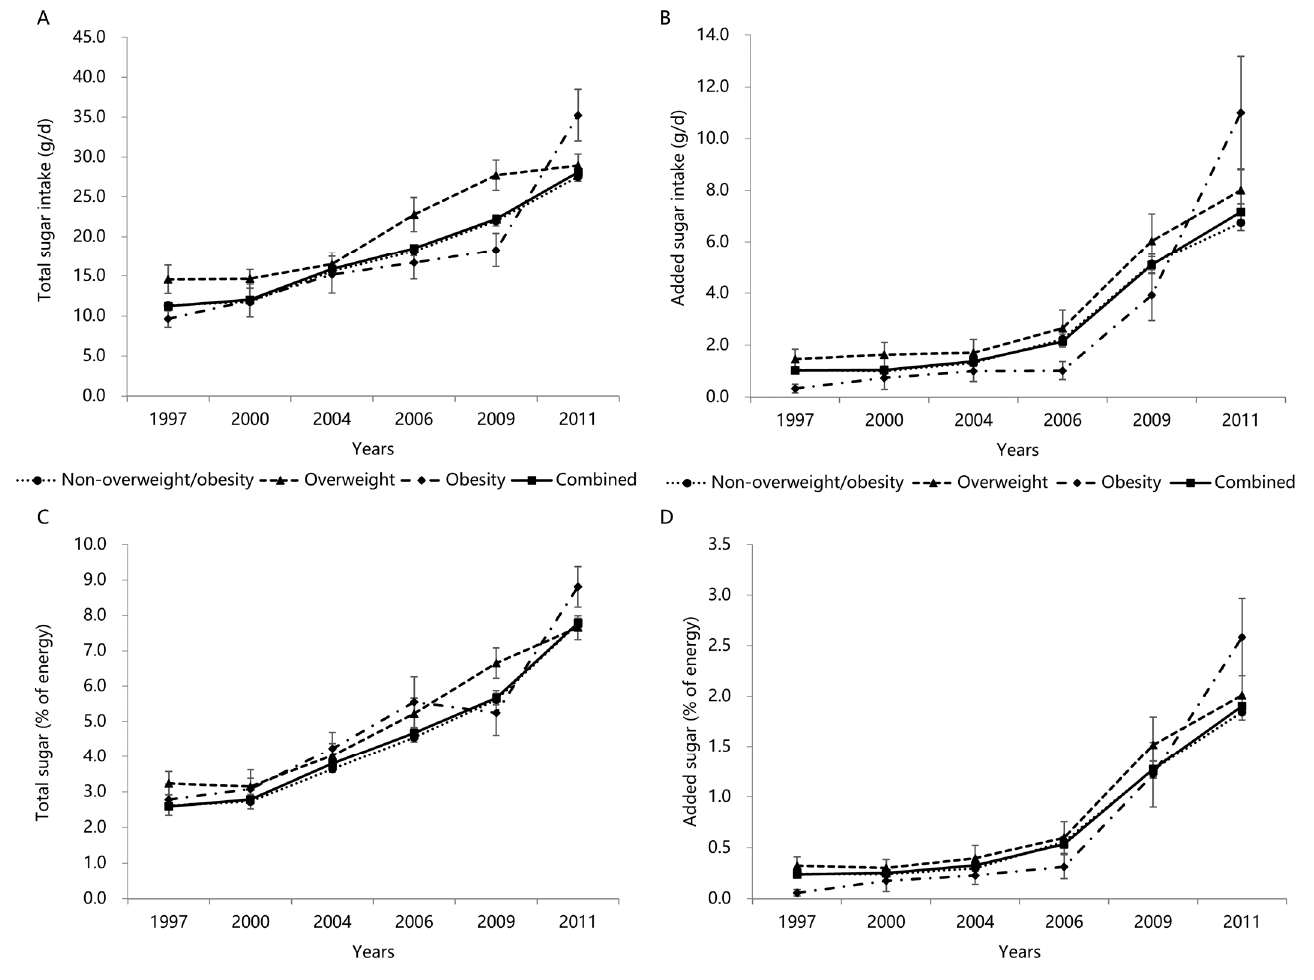
Figure 4. Mean (±SE) trends in total sugar intake ( A ), added sugar intake ( B ), total sugar (%E) ( C ), and added sugar (%E) ( D ) in Chinese children and adolescents by BMI categories, CHNS 1997–2011. All results of linear trends by BMI categories using general linear regression were p < 0.001.